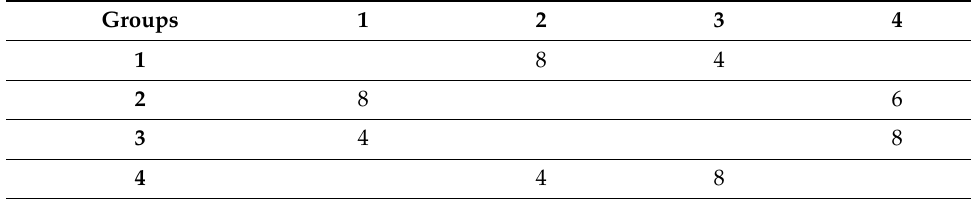
Table 5. The communication packets after grouping.